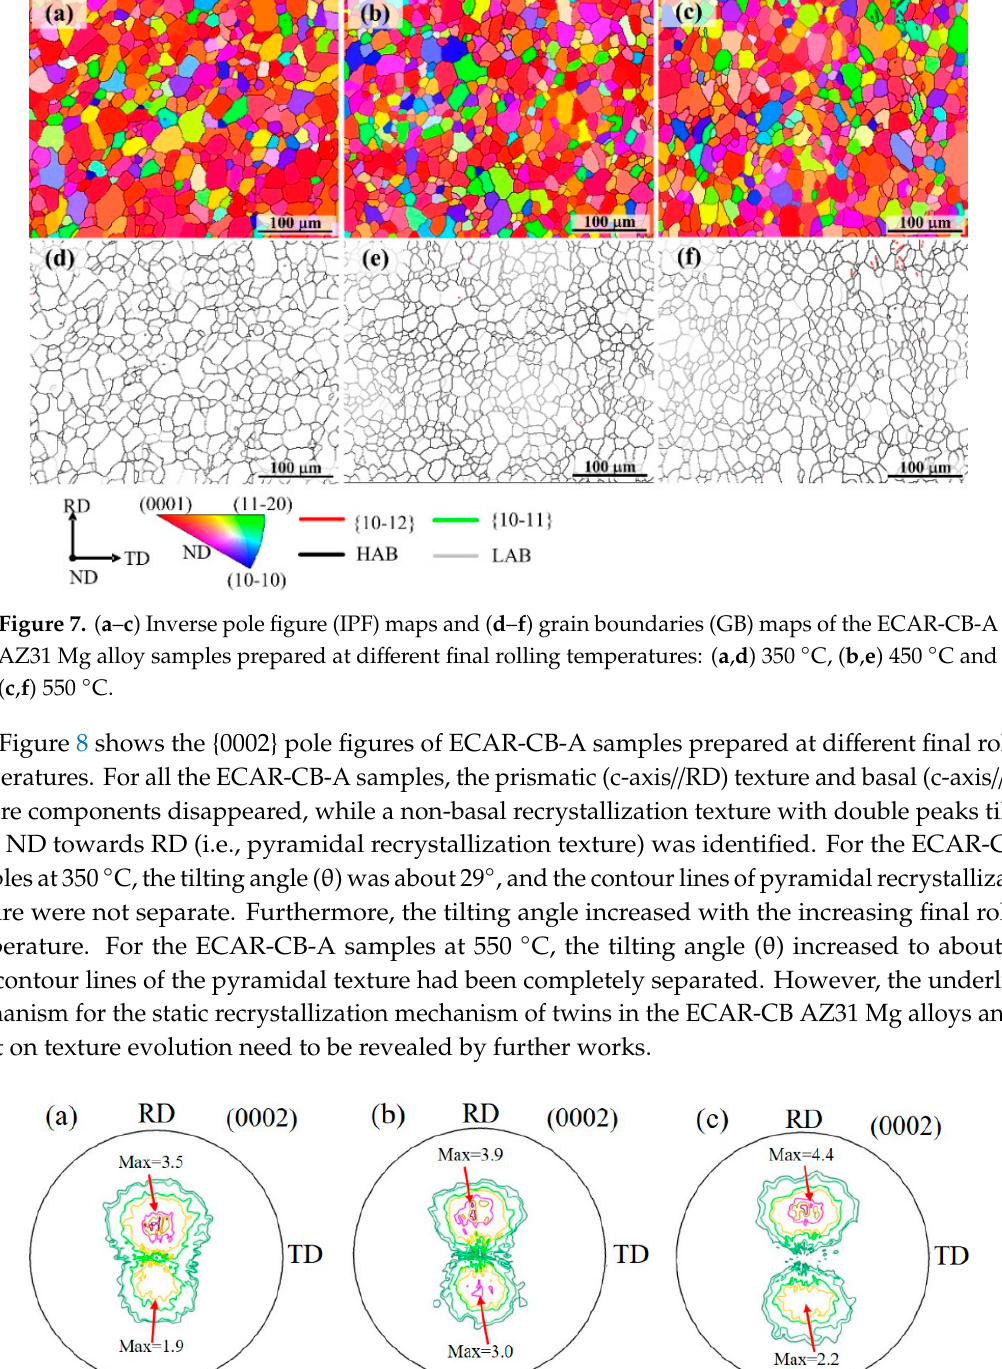
Figure 8. Pole figures (0002) of the ECAR-CB-A AZ31 Mg alloy samples prepared at different final Table 2. Mechanical properties of various ECAR-CB-A samples prepared at different final rolling rolling temperatures: ( a ) 350 ◦ C, ( b ) 450 ◦ C and ( c ) 550 ◦ rolling temperatures: ( a ) 350 °C, ( b ) 450 °C and ( c ) 550 °C. temperatures.